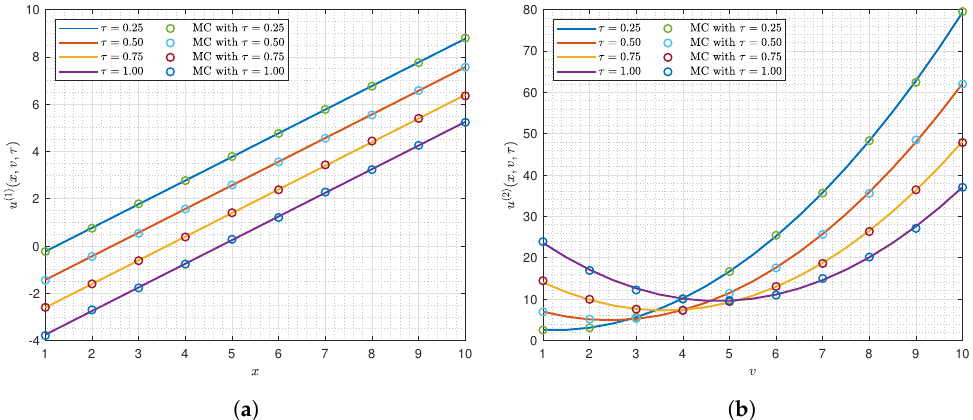
Figure 3. Validation tests of the first and second conditional moments for the initial values v = 10 and x = 1,2,3, . . . ,10 at different τ = 0.25,0.5,0.75, 1. ( a ) The first conditional moment u ( 1 ) ( x ,10, τ ) . ( b ) The second conditional moment u ( 2 ) ( x ,10, τ ) . Table 1. MAEs of the first conditional moment u ( 1 ) ( x , v ,1 ) between our formula and the MC simula- tions together with the average runtimes of the MC simulations.